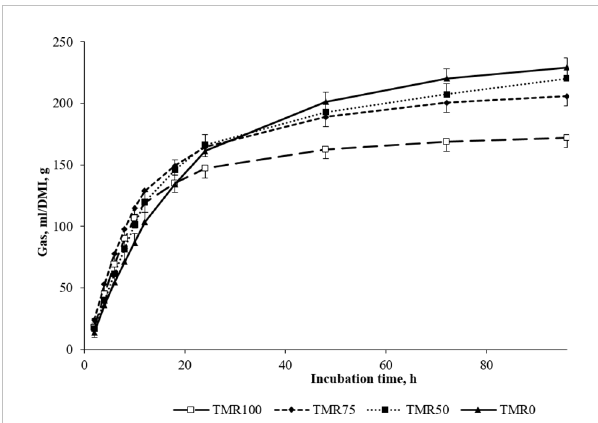
FIGURE 1 In vitro gas production (mL/DM incubated, g) using ruminal liquor of lambs fed TMR (TMR100), 75% TMR and alfalfa (TMR75), 50% TMR and alfalfa (TMR50), or only alfalfa (TMR0) as inocula (mean values ± standard